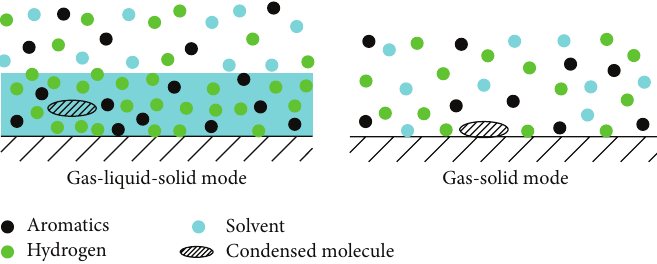
Scheme 1: Illustration of gas-liquid-solid and gas-solid reaction